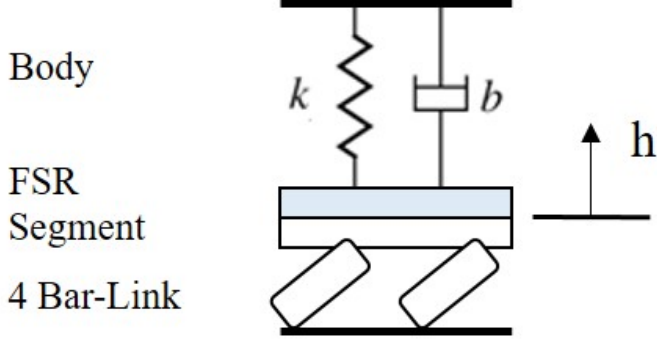
Figure 6. System model for the control .